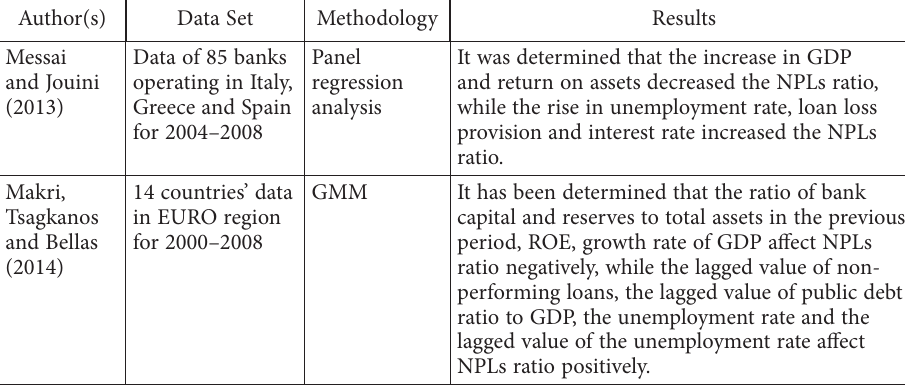
Table 1. The related studies in the literature (source: compiled by the